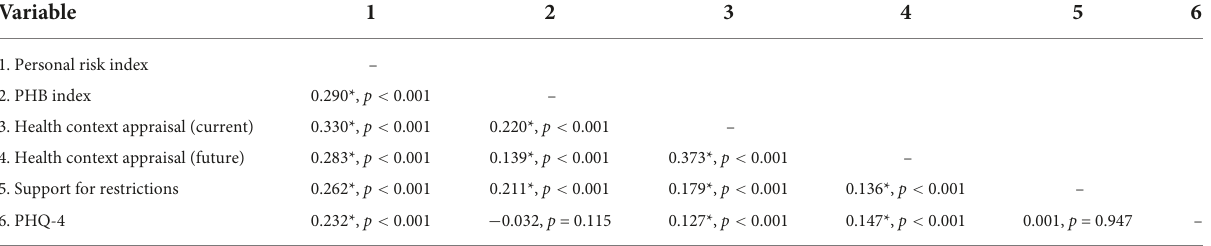
TABLE 4 Pearson’s correlations between risk perceptions, protective behaviors, support for restrictions, and psychological distress measures.